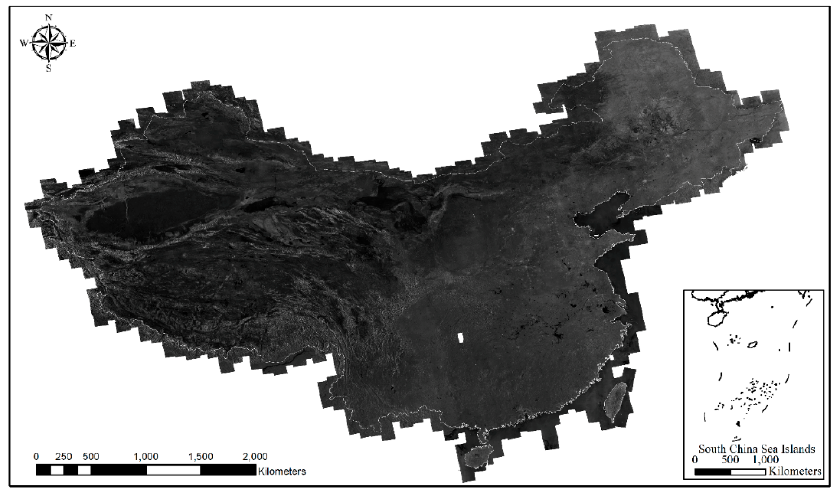
Figure 7. Gaofen-3 (GF-3) SAR digital orthophoto map (DOM) of China.